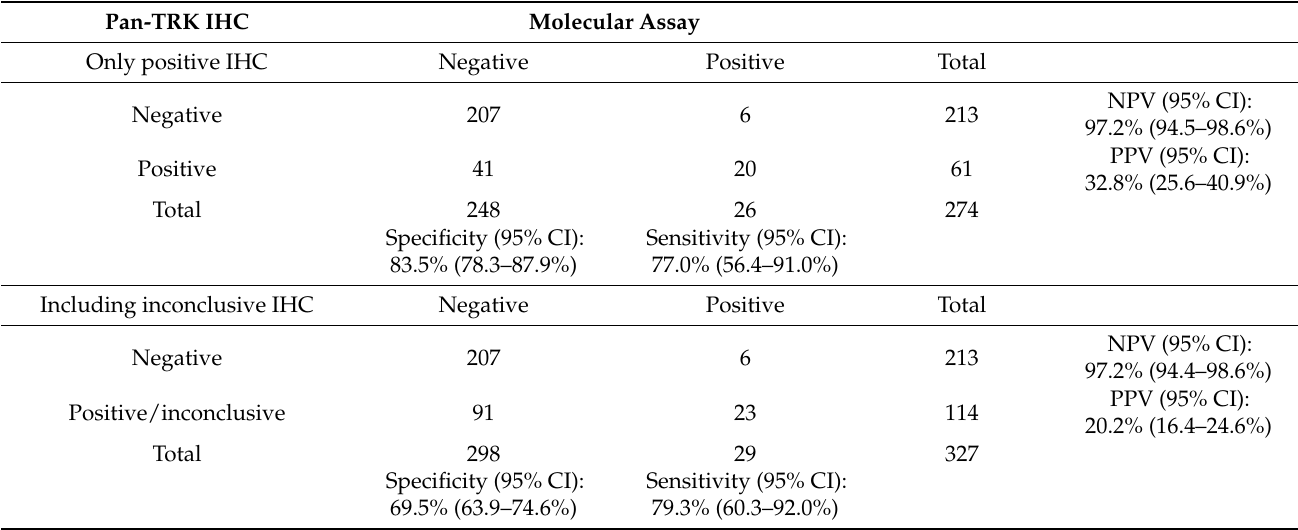
Table 2. Sensitivity and specificity of pan-TRK IHC as a screening tool for NTRK fusions with molecular assay as a